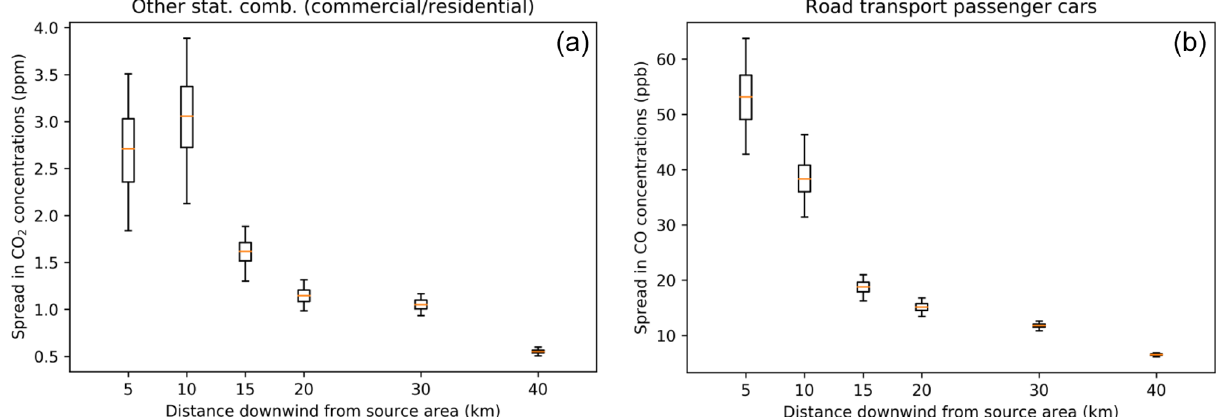
Figure 10. Spread in simulated concentrations of CO 2 resulting from commercial/residential emissions due to uncertainties in the total population proxy map (a) and spread in concentrations of CO resulting from road transport (passenger cars) emissions due to uncertainties in the passenger cars proxy map (b) . The box represents the interquartile range, the whiskers the 2.5–97.5 percentiles, and the lines the median values of the full